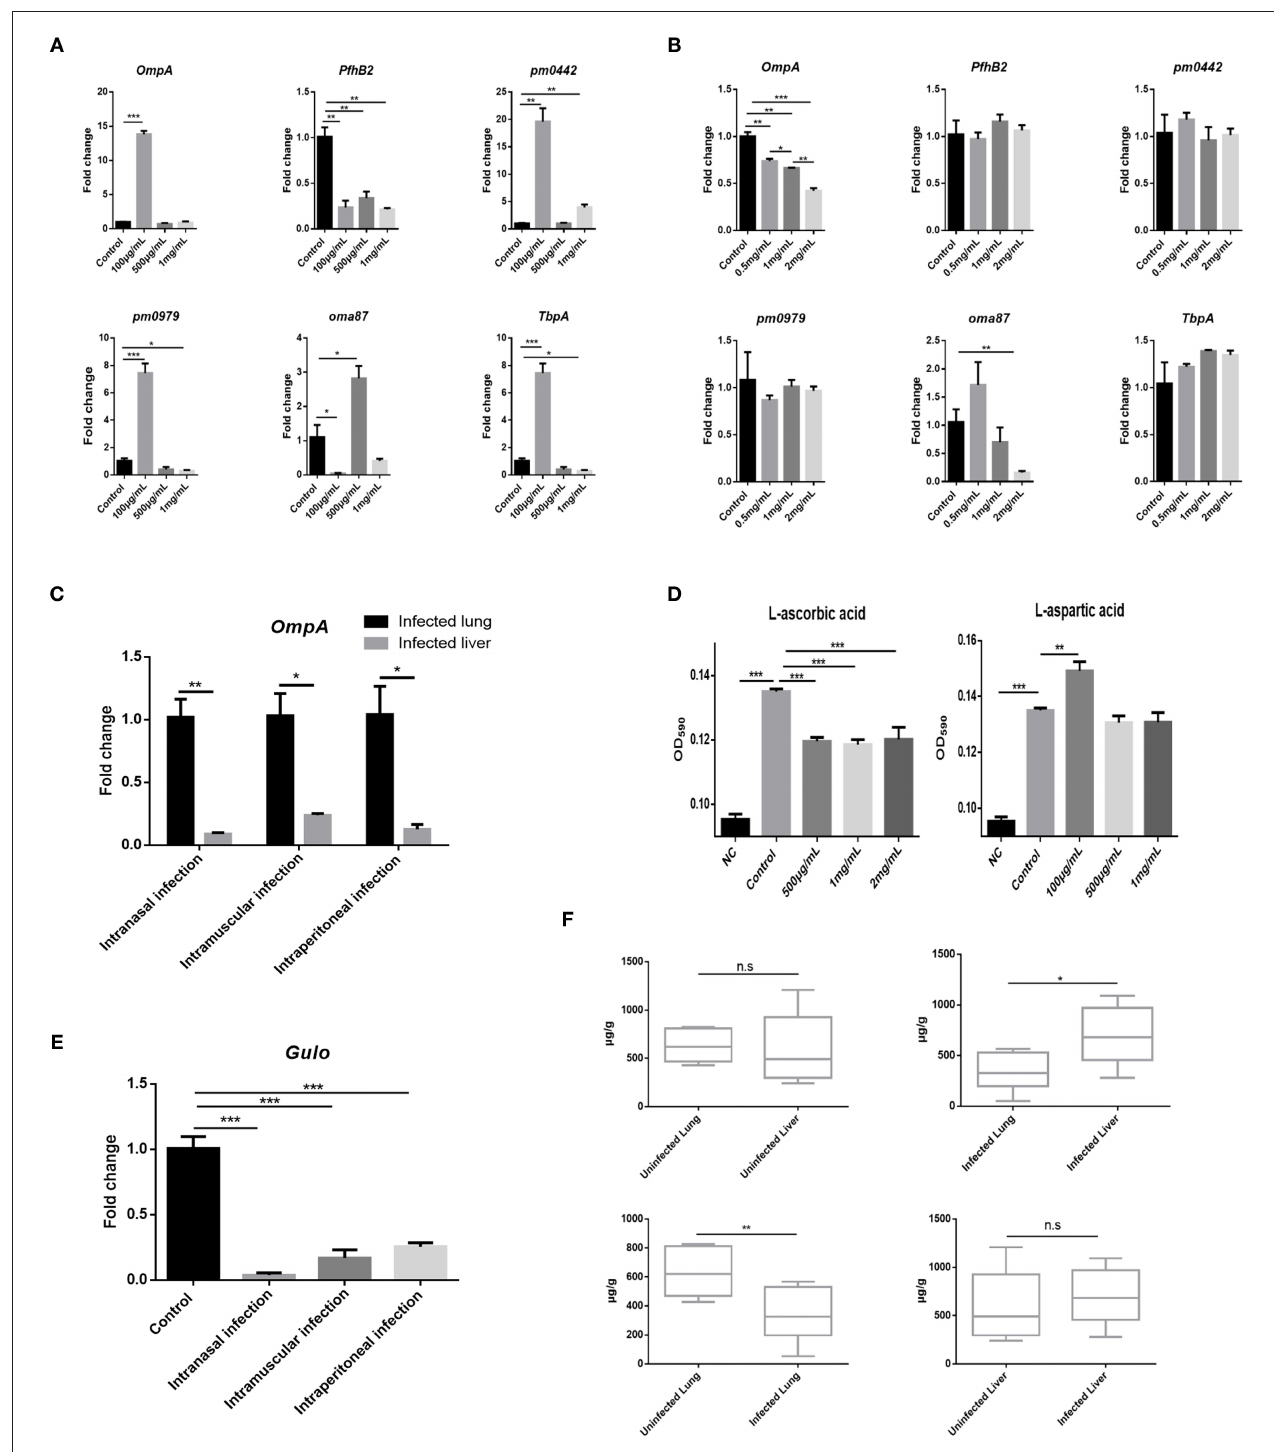
FIGURE 3 | AA inhibited PmCQ2 virulence factor expression and its concentration was downregulated in the lung after PmCQ2 infection. (A) Analysis of some PmCQ2 virulence gene expression under different doses of AA. (B) Analysis of some PmCQ2 virulence gene expression under different doses of L-aspartic acid. Three repeats for each group. (C) PmCQ2 bioflim formation treated with different doses of AA or L-aspartic acid. Five repeats for each group. (D) The virulence gene, OmpA , expressions in the mice lung before infection or after 10 4 CFU log-phase growth PmCQ2 infection for 16h. Three repeats for each group. (E) The AA biogenesis gene Gulo expressions in the mice lung before infection or after receiving 10 4 CFU log-phase growth PmCQ2 infection for 16h. Three repeats for each group. (F) Comparison of AA concentrations in health mice lung and liver with mice intranasally infected with 10 4 CFU log-phase growth PmCQ2 for 32h. Six repeats for each group. *, **, and *** represent P < 0.05, P < 0.01, and P < 0.001, respectively.